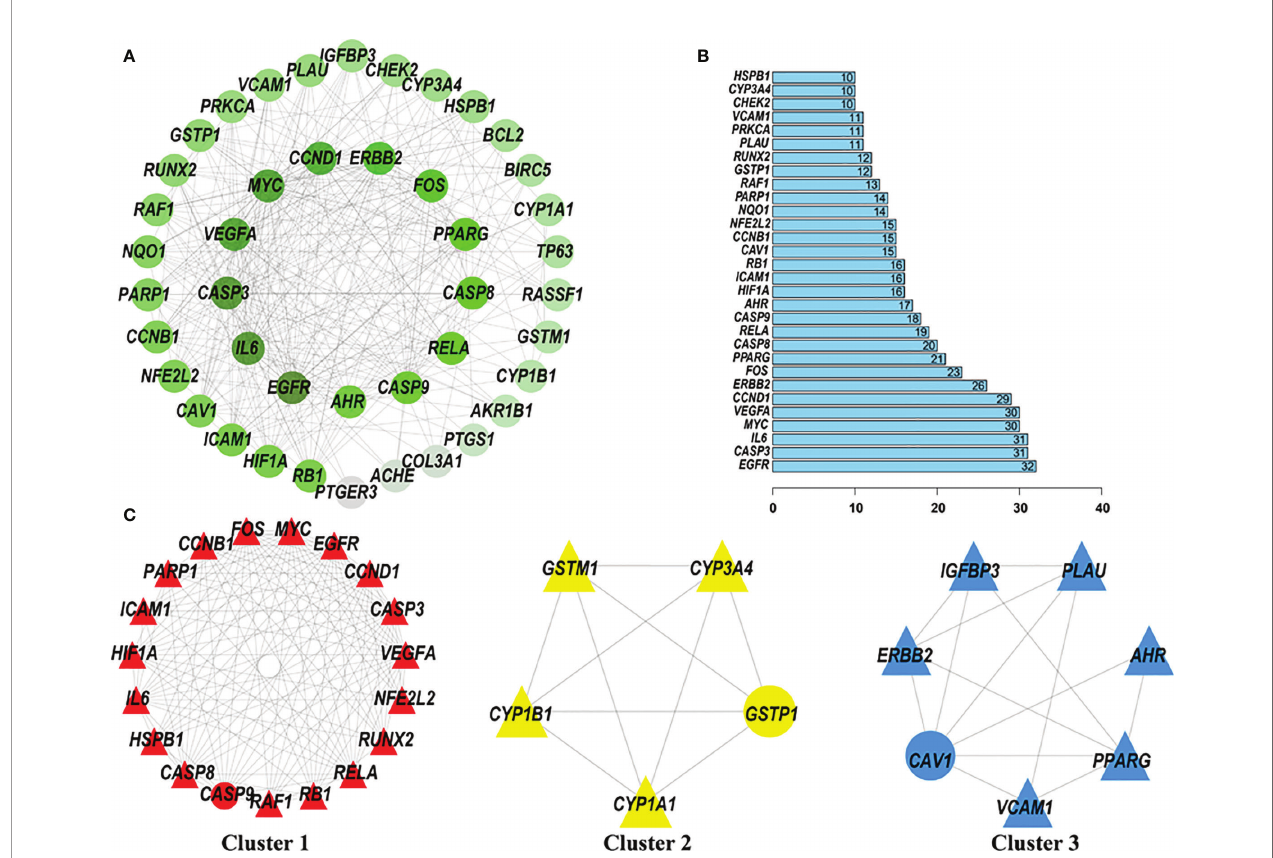
FIGURE 5 | Protein-protein interaction (PPI) network of quercetin and cisplatin anti-cervical cancer genes. The MCODE algorithm was applied to this network to identify neighborhoods where proteins were densely connected. The gradient from dark green to light green represents the change in the number of edges from more to less; three signi fi cant modules with a score >4.5 were selected. (A) PPI network of quercetin and cisplatin anti-cervical cancer genes. (B) Histogram of key proteins. The y-axis represents the name of genes, the x-axis represents the number of adjacent genes, and height is the number of gene connections. (C) Module 1, MCODE score = 14.111; Module 2, MCODE score = 5; and Module 3, MCODE score = 4.667.